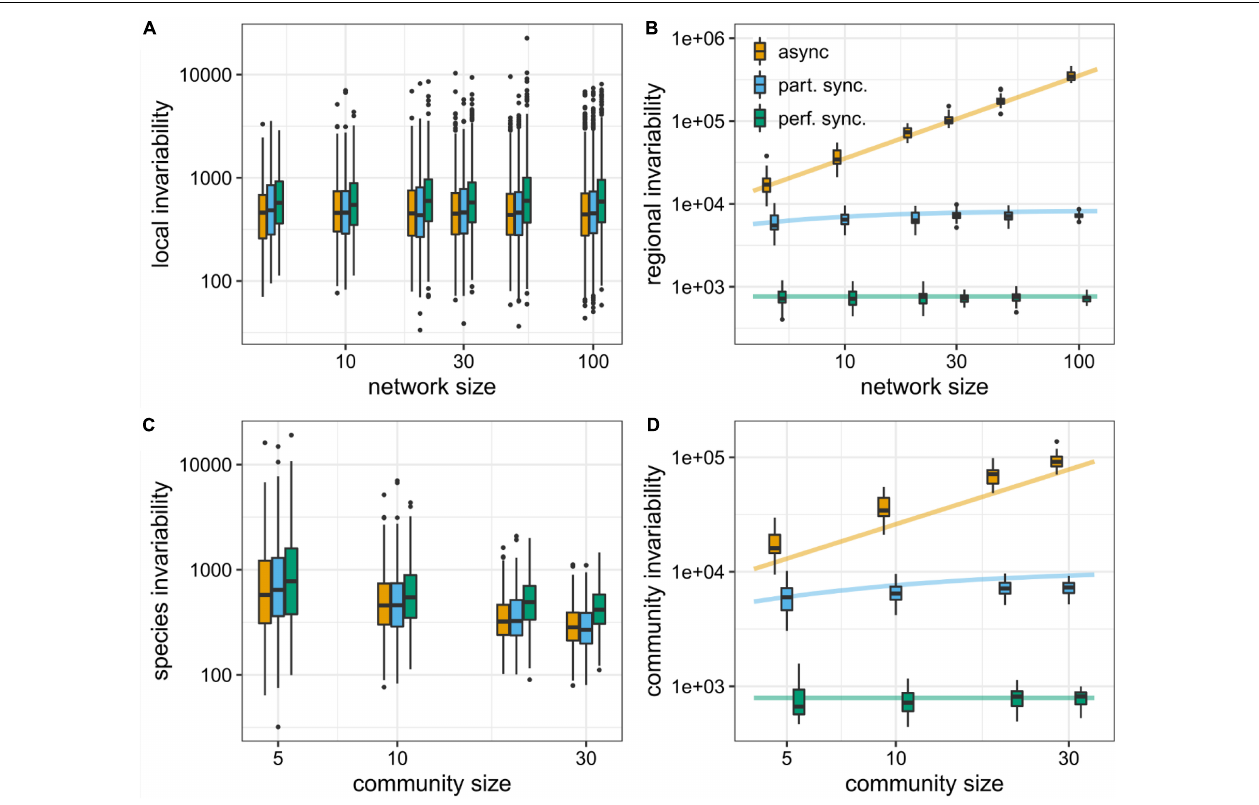
FIGURE 6 | Local (A) and regional (B) invariability estimates in random spatial networks of random communities of 10 competitor species, for different sizes of the spatial network; and species (C) and community (D) invariability estimates of random communities of competitors at 10-node random spatial networks, for different number of species forming the communities. In (A,B) , we have considered three different scenarios: asynchronous local dynamics ( c = 0, yellow box plots), partially synchronous local dynamics ( c = 0 . 36, blue), and perfectly synchronous local dynamics ( c = 1, green). In (C,D) , we have considered the cases of asynchronous ( ˜ c = 0), partially synchronous ( ˜ c = 0 . 17) and perfectly synchronous ( ˜ c = 1) species dynamics. Solid lines depict the invariabilities predicted by analytical expressions (Eqs. 20–22), and analogous expressions for community